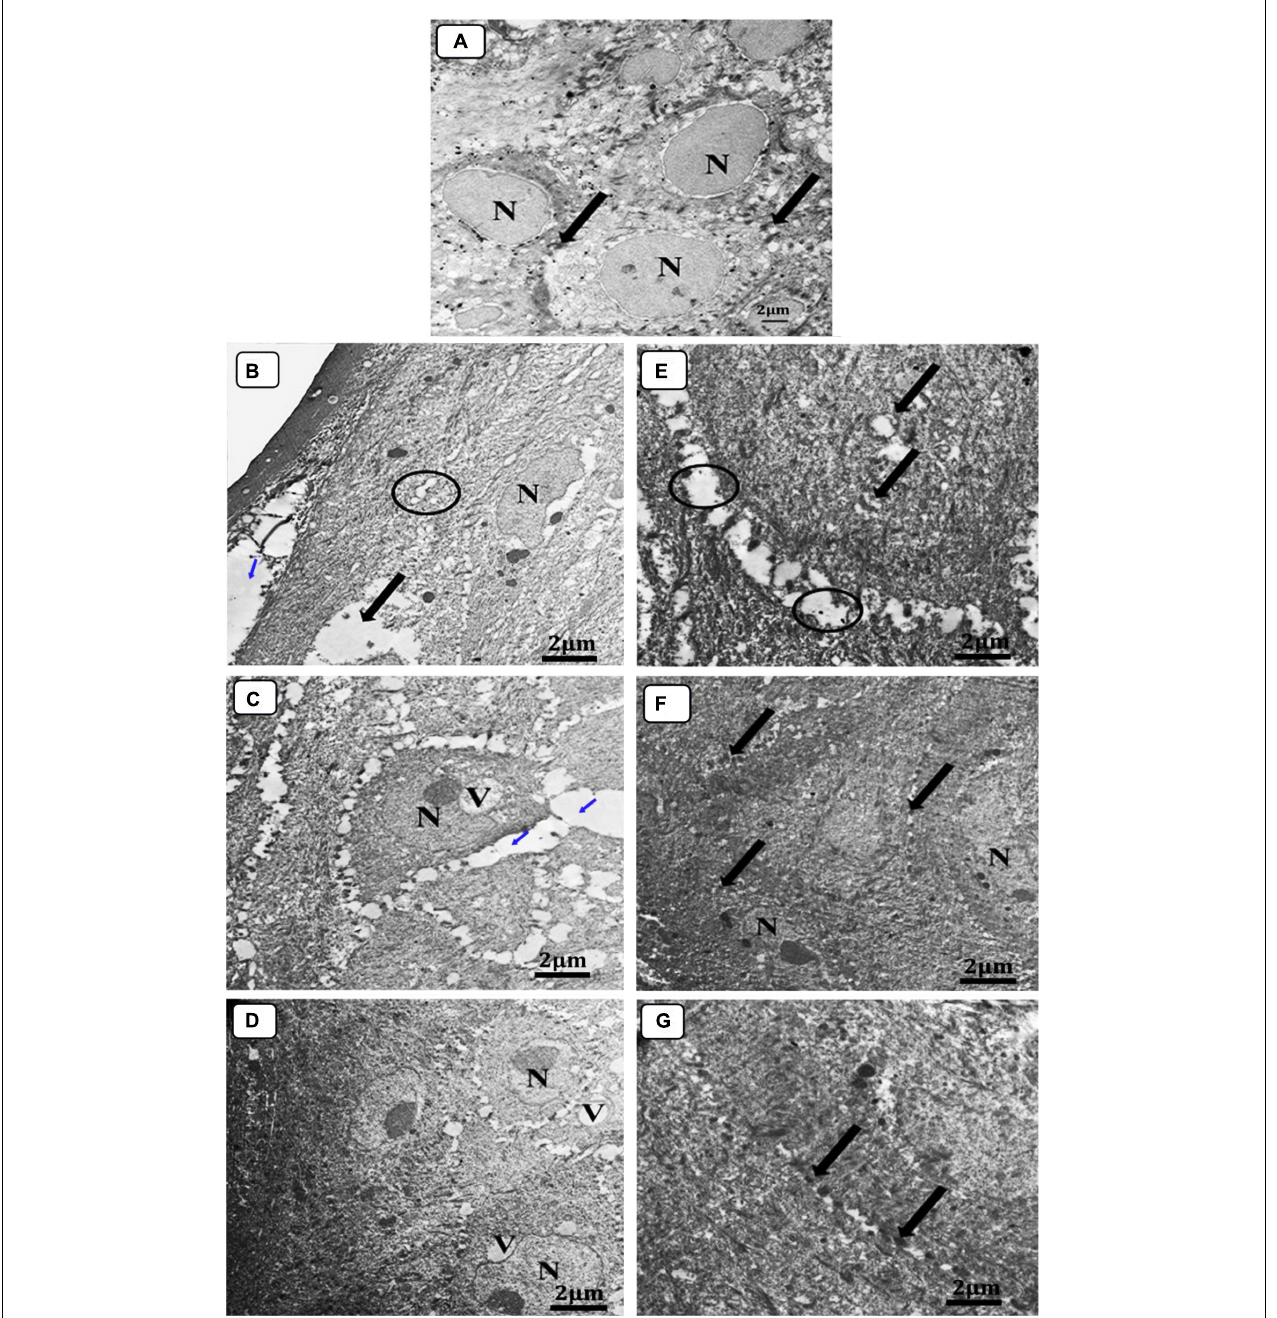
FIGURE 10 | Electron micrograph of skin sections. (A) Normal group (negative control), (B) infected, and untreated (positive control), (C) infected, and treated with placebo base gel (positive control), (D) infected, and treated with Ag-NPs gel, (E) infected, and treated with neomycin gel, (F) infected, and treated with neomycin-Ag-NPs gel, and (G) infected, and treated with neomycin- Ag-NPs spray. (A) Normal epidermis layer in G1 normal oval nucleus (N) surrounded by homogenous cytoplasm with intact desmosomes and to no filaments (arrow). (B) Normal dermis layer, G2 separation between the upper layer of epidermis with widening in the intracellular spaces between the cells (blue arrow), disrupted desmosomes (circle), rarified cytoplasm (thick arrow), and irregular nucleus (N) surrounded by small lytic areas, (C) loss of desmosomes with large separation between the cells (blue arrow), degenerated mitochondria, and a large vacuole (V) that compresses the nucleus causing irregulation of the nucleus (N). (D) Start healing appearance in the superficial layer while the middle layer still shows irregular nucleus (N) and cytoplasmic vacuolation (V) with less intracellular spaces between cells most of desmosomes are complete and most of the mitochondria are probably normal. (E) Swollen degenerated mitochondria (thick arrow), rarified cytoplasm and disrupted of desmosomes (circle). (F) Mild irregular nucleus (N), most of the desmosomes are completely intact (thick arrow) and most of the cells are probably normal. (G) Most probably normal epidermis layer, and almost all desmosomes are intact (thick